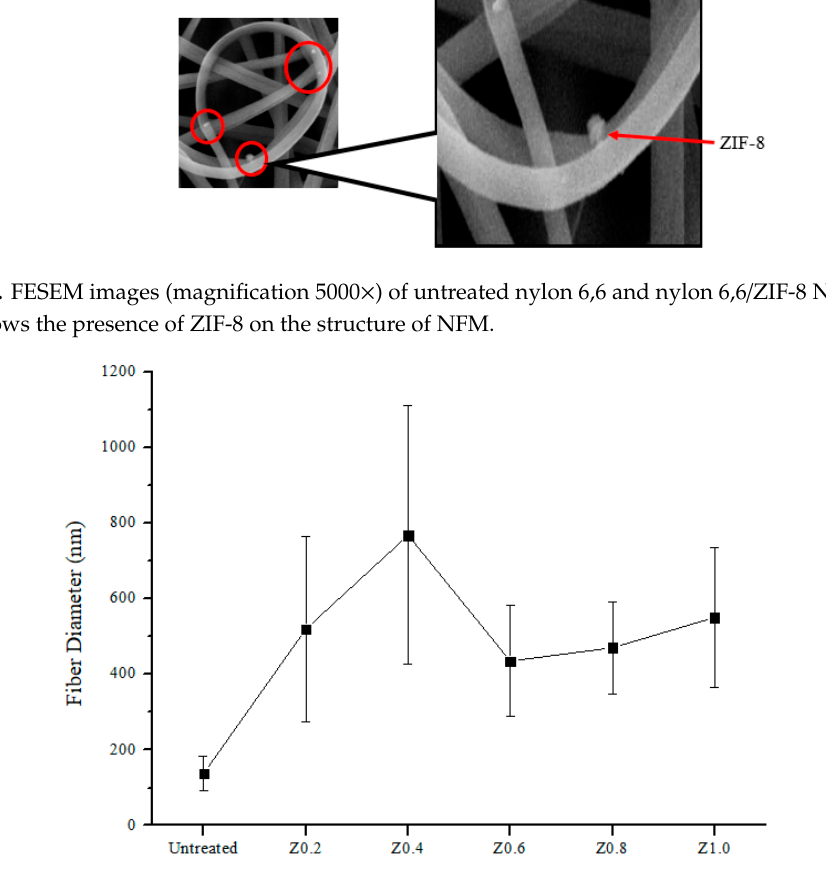
Figure 5. A plot of fiber diameter according to different loading of ZIF-8.